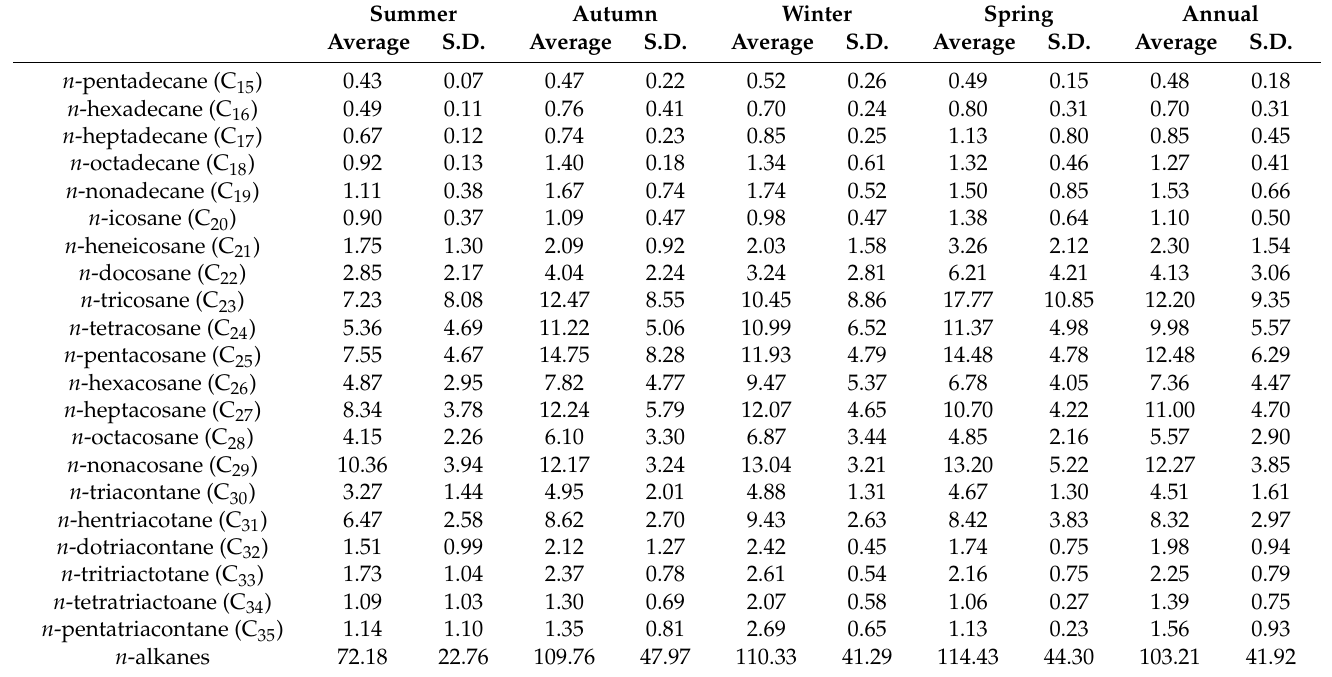
Table 2. Mass concentration of n-alkane (ng/m 3 ) components in PM 2.5 at TC,